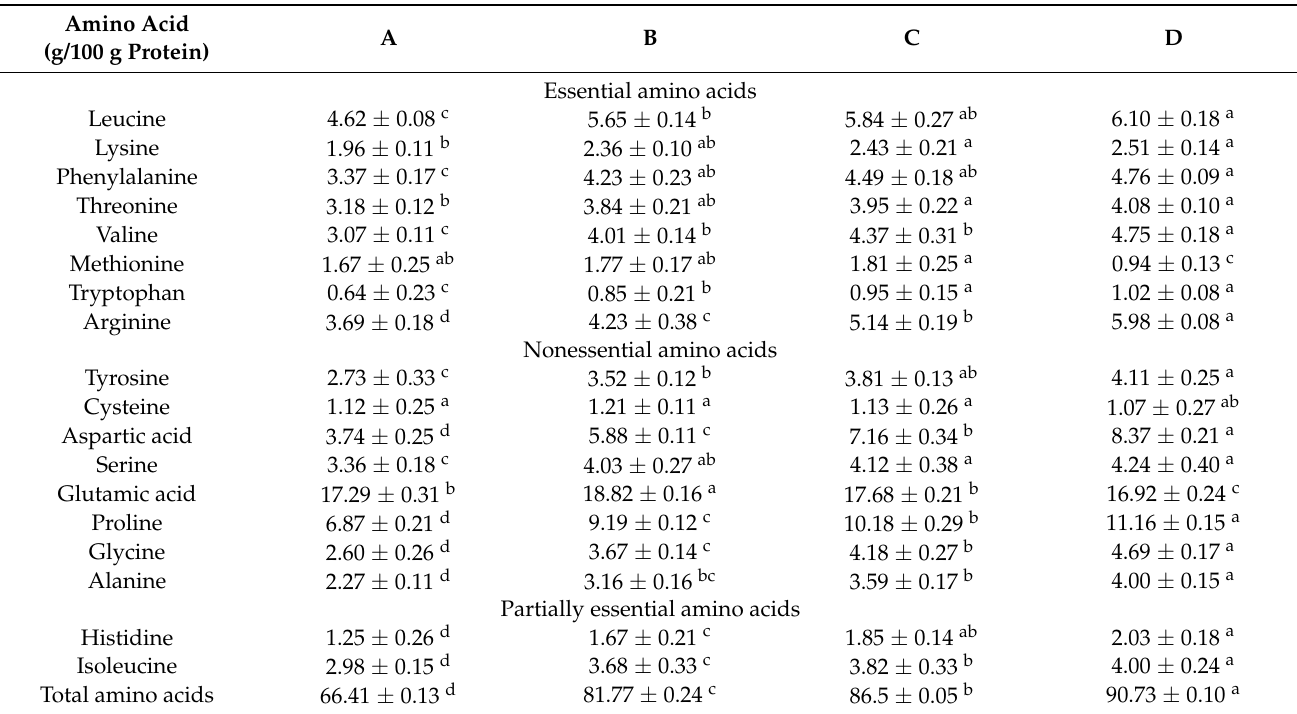
Table 1. Amino acid composition of rice